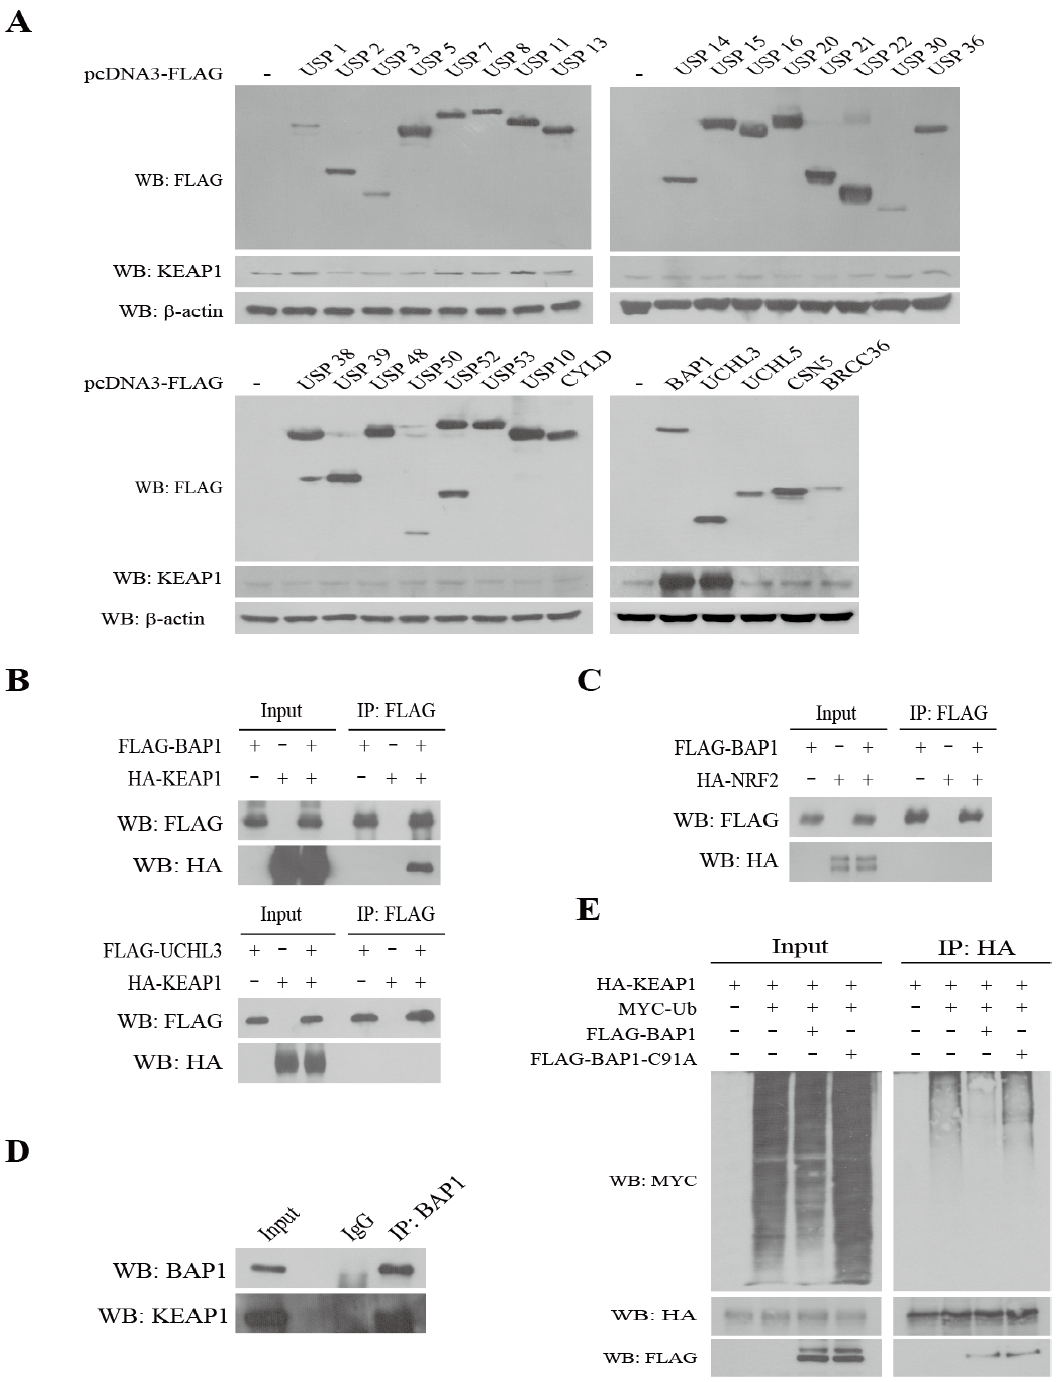
Figure 1. BAP1 directly binds to and deubiquitinates KEAP1. ( A ) Overexpression of BAP1 and UCHL3 induces KEAP1 in 293T cells. One µ g of pcDNA3-FLAG-DUBs was transfected to 293T cells (2.0 × 10 6 cells/100 mm dish) for 24 h and Western blot analysis conducted against KEAP1. ( B ) FLAG-BAP1 directly binds to HA-KEAP1. One µ g of pcDNA3-FLAG-BAP1 ( upper panel ) or 1 µ g of pcDNA3-FLAG-UCHL3 ( lower panel ) were cotransfected with 1 µ g of pcDNA3-HA-KEAP1 for 24 h in 293T cells (2.0 × 10 6 cells/100 mm dish). The 293T cell lysates were immunoprecipitated with FLAG magnetic beads, and Western blot analysis was performed with FLAG-HRP and HA-HRP antibodies. ( C ) FLAG-BAP1 does not bind to HA-NRF2. One µ g of pcDNA3-FLAG-BAP1 was cotransfected with 1 µ g of pcDNA3-HA-NRF2 for 24 h in 293T cells (2.0 × 10 6 cells/100 mm